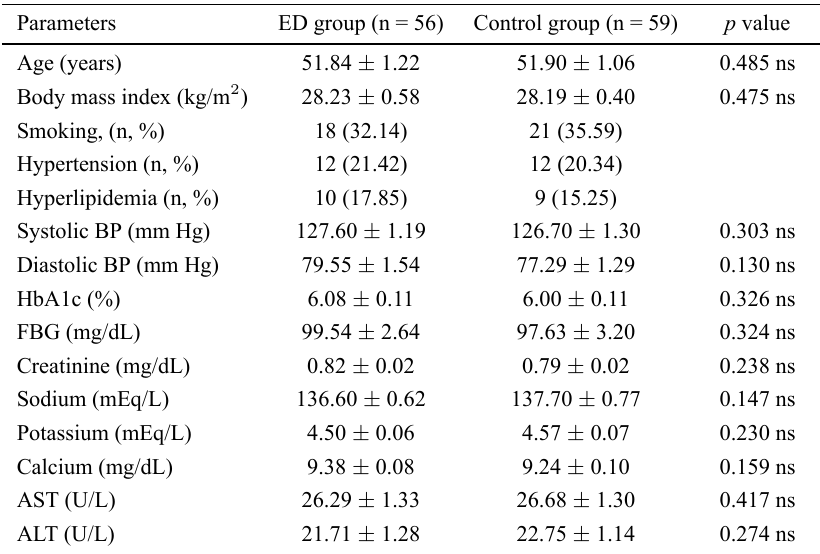
Table 1. Comparison of clinical, demographic, and laboratory parameters in erectile dysfunction (ED) patient and healthy